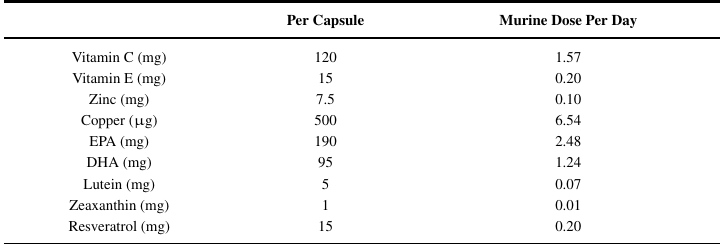
Figure 1. Retinal fluorescein angiography (FA). Characteristic retinal FA images obtained 48 h after laser application (FA1) and after four weeks of oral treatment (FA2) in the vehicle group (V), the nutritional supplement group (S), the vehicle and anti-vascular endothelial growth factor (VEGF) group (V + aVEGF), and the nutritional supplement + anti-VEGF group (S + aVEGF). There were 15 mice in each group. Differences between treated and vehicle groups were statistically significant ( p < 0.05). Table 1. Nutritional daily supplement composition per capsule and per mouse (assuming a mean weight of 30 g). Data are expressed in mg/kg body